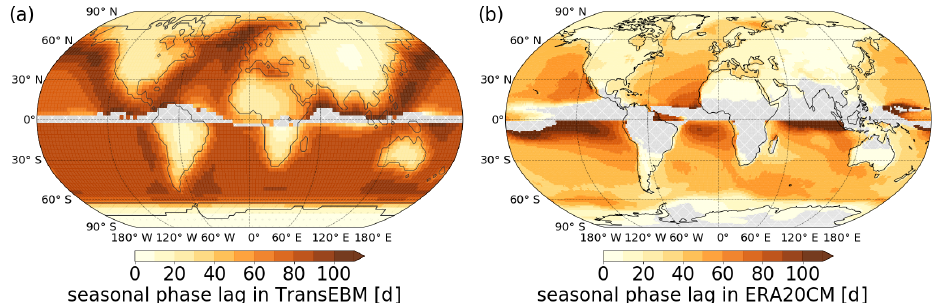
Figure 11. Phase lag of the seasonal cycle in surface temperature in days after solar forcing (solstice) in a 20th century run of TransEBM v. 1.0 and ERA-20CM. The TransEBM simulation is the same as in Fig. 10. The phase lag uses sinusoids fitted to the seasonal cycle. Areas where the seasonal cycle does not follow a clear sine were excluded from the analysis and are shown in grey. TransEBM simulates larger phase lags in comparison to the reanalysis (particularly over the oceans).